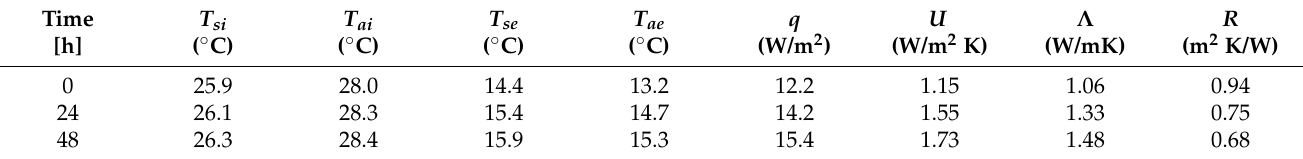
Table 5. Collected data and resulting thermal properties for single time steps.